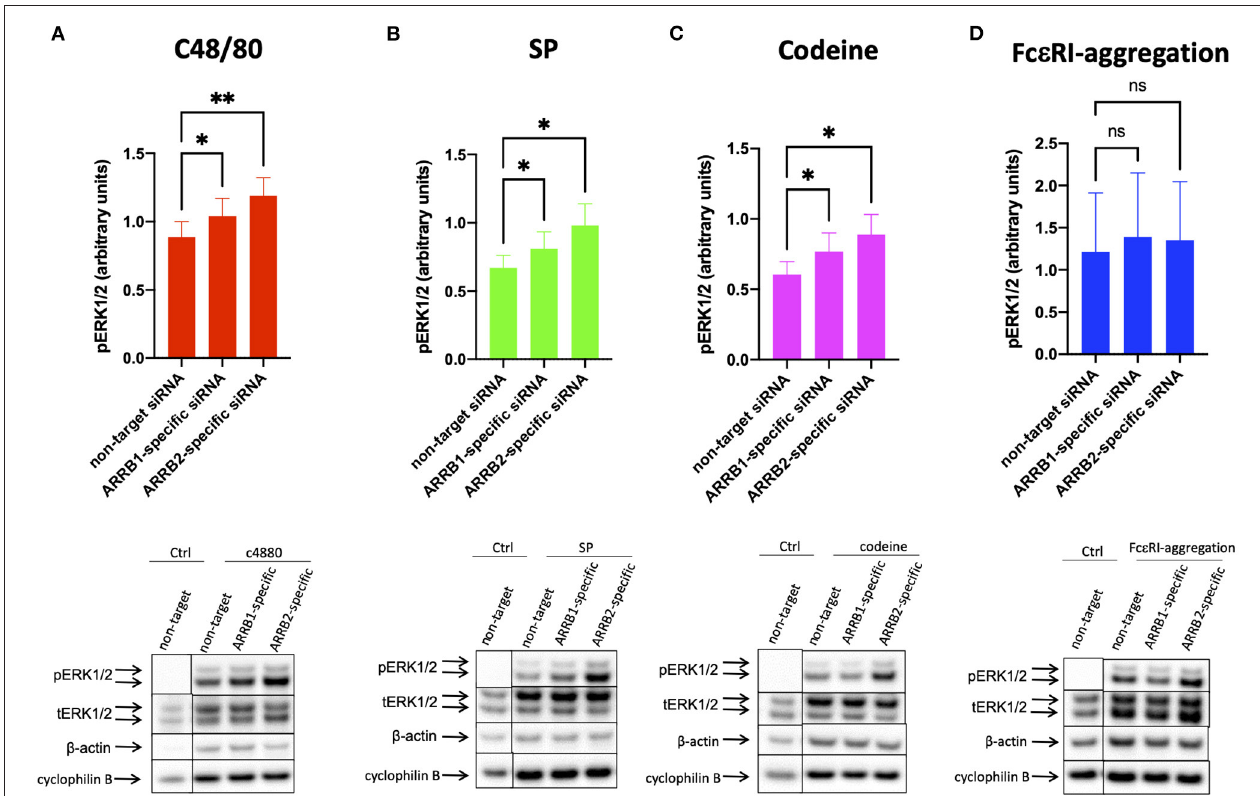
FIGURE 3 | β -arrestin-1 and β -arrestin-2 interfere with MRGPRX2-mediated ERK1/2 phosphorylation. MCs were treated with ARRB1-selective, ARRB2-selective, or non-target siRNA for 48h. The cells were then activated by (A) c48/80 (10 µ g/ml), (B) SP (30 µ M), (C) codeine (100 µ g/ml) for 1min, or (D) Fc ε RI aggregation (AER-37, 0.1 µ g/ml) for 30min, respectively. Cells with no stimulus are given for comparison. Phosphorylated (p) and total (t) ERK as well as β actin and cyclophilin B were detected and quantified consecutively on the same membranes. (A–D) upper panel: relative pERK normalized against tERK expression; lower panel: representative blots showing pERK and all loading controls. The data are shown as mean ± SEM of 4–12 independent experiments (individual cultures). * p < 0.05, ** p < 0.01, and ns, not